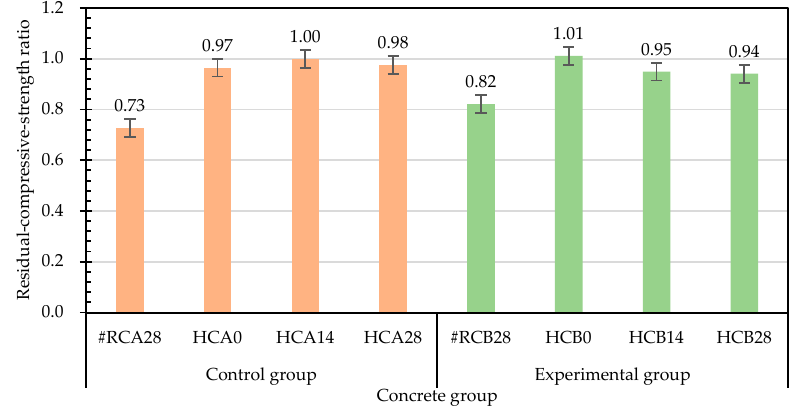
Figure 19. Effects of different test parameters on the relative-compressive-strength ratios of concrete.